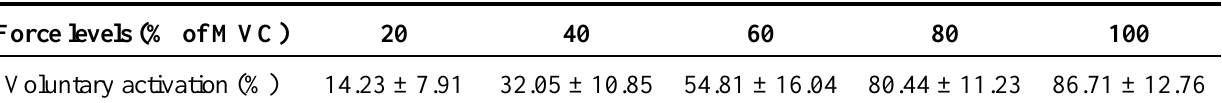
Table 1. Average and standard deviation of voluntary activation across true voluntary contraction force levels (N =